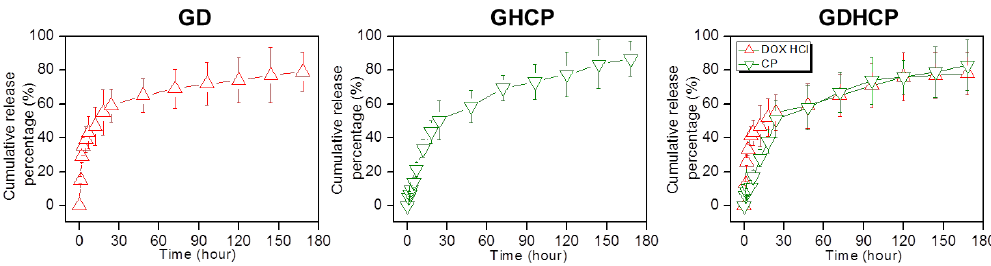
Figure 2. Cumulative release percentages of DOX · HCl and / or CP in GD, GHCP and GDHCP measured at day 1, 3, 6, 12, 24, 48, 72, 96, 120, 144, and 168 h. This experiment was performed three times in PBS (pH 7.4) at 37 °C.